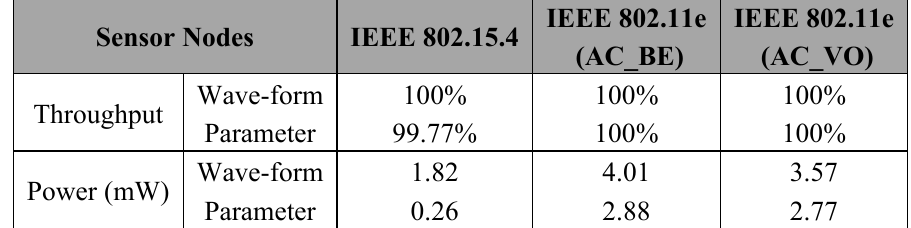
Table 4. Throughput and Power (in mW) of IEEE 802.15.4 and IEEE 802.11e under AC_BE and